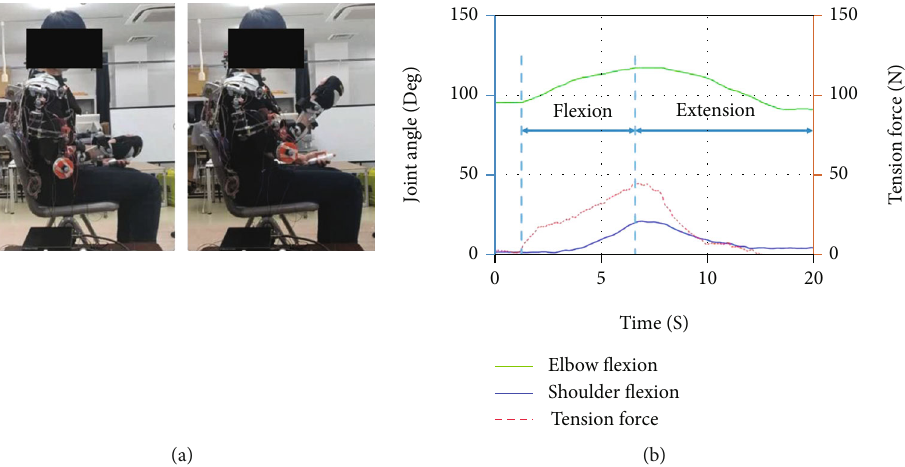
Figure 5: Subject wearing an assistive device performing maximum shoulder fl exion and extension to the initial position. The arm ’ s initial position was kept in front of the inner side of the frontal body of the subject. The elbow was fl exed to the maximum and returned to the initial position. Data (b) shows measured elbow fl exion angle, shoulder fl exion angle, and tension force versus time.